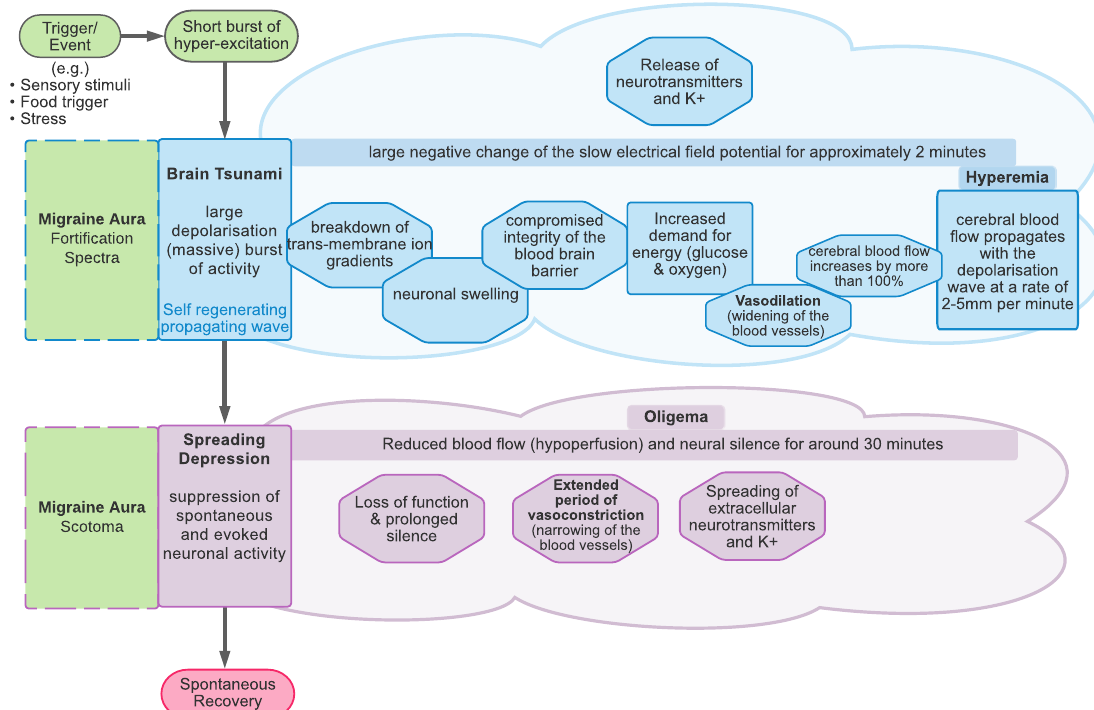
Figure 3. Cortical spreading depolarisation and depression in migraine. Spreading depression and the migraine scotoma start simultaneously with the onset of the negative potential shift of the deplorisation (brain